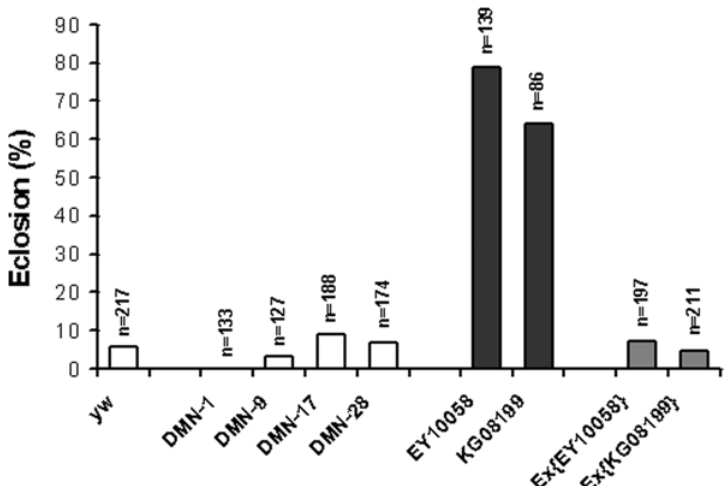
Figure 6. Precise-excision of P-elements in genomic region of gene sec6 reverses hypoxia tolerance. Survival of precise excision lines for P - element insertion targeting gene sec6 was de- termined in hypoxic condition. Embryos from each precise excision line were collected and cultured in 5% O 2 . Total and eclosed pupae were counted and the ratio of eclosion for each allele was compared to that of yw , NF controls and original P -element alleles. Each bar represents the average of at least three tests of individual excision line. The total number of scored pupae was indicated over each bar. The statistical significance was obtained when p values were , 0.001 (Chi-squared